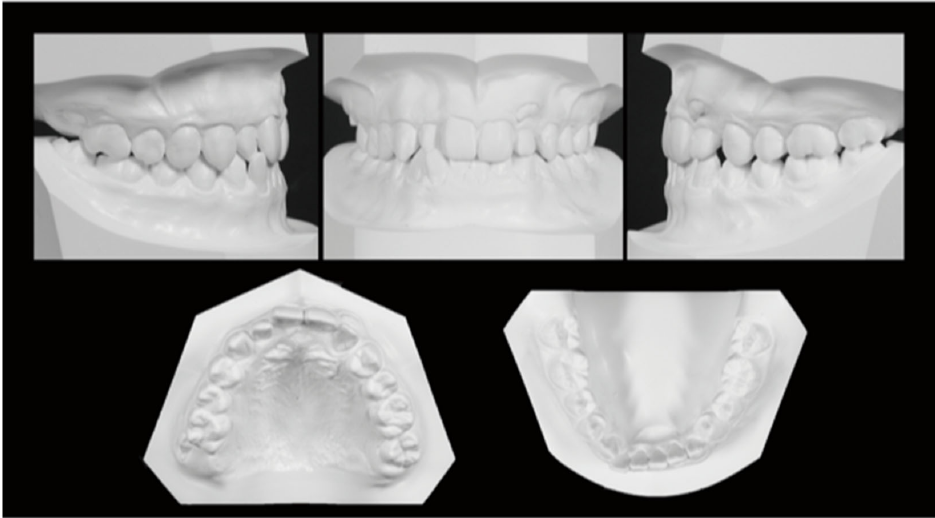
Figure 1. Initial facial and intraoral photographs (age, 14 years 4 months).